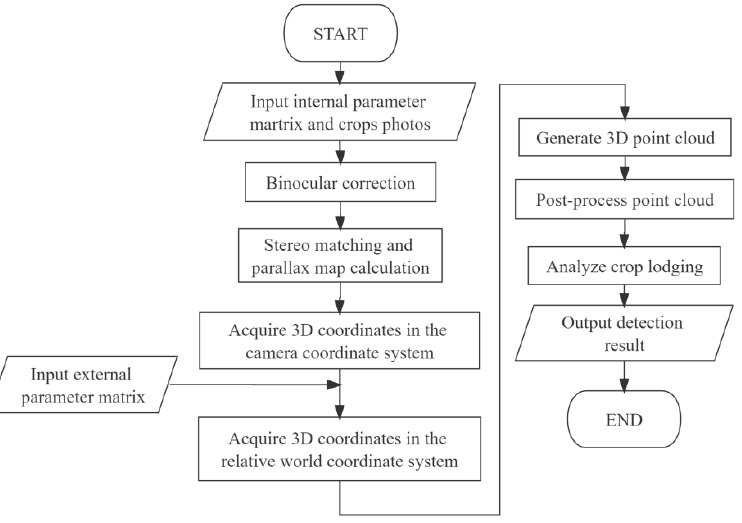
Figure 4. Wheat lodging image processing algorithm flowchart.